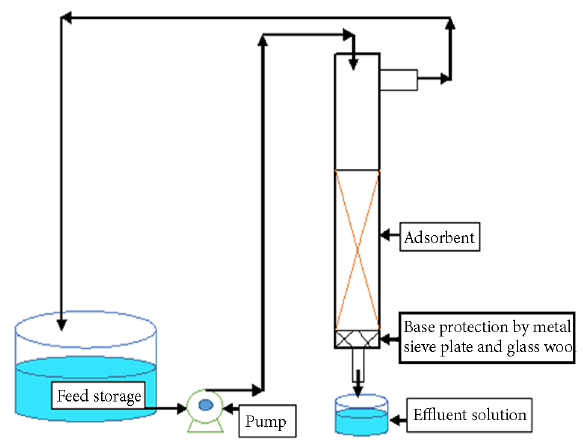
Figure 2. Experimental set-up (schematic